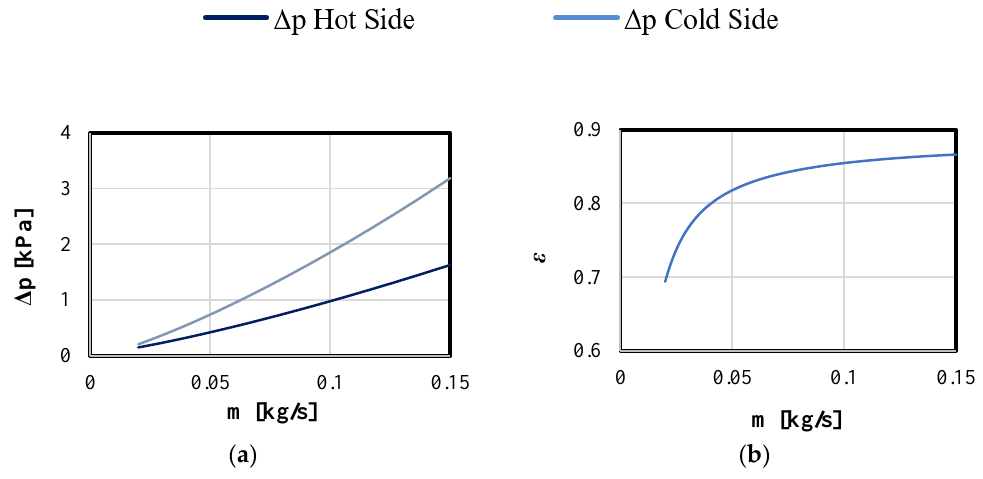
Figure A2. ( a ) Pressure drop across the recuperator as a function of the mass flow rate for both cold and hot side; ( b ) recuperator effectiveness as function of the mass flow rate.